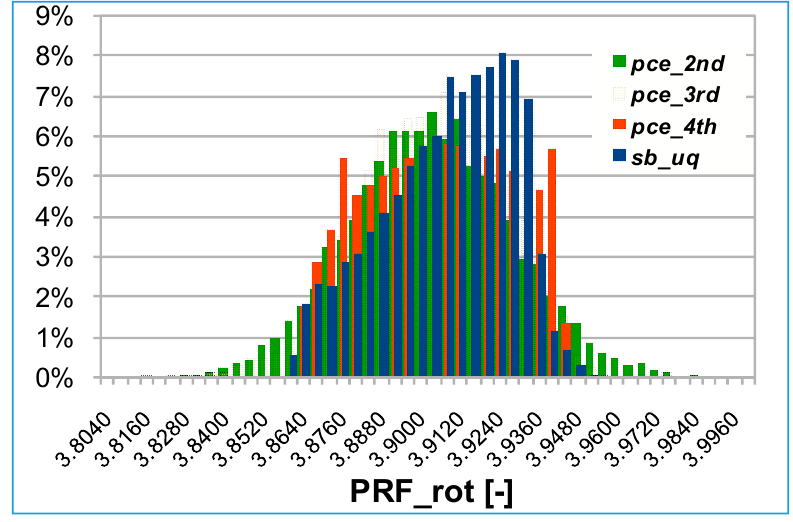
Figure 15. PCE vs. SB-UQ: rotor pressure ratio probability distributions coming from different polynomial orders.